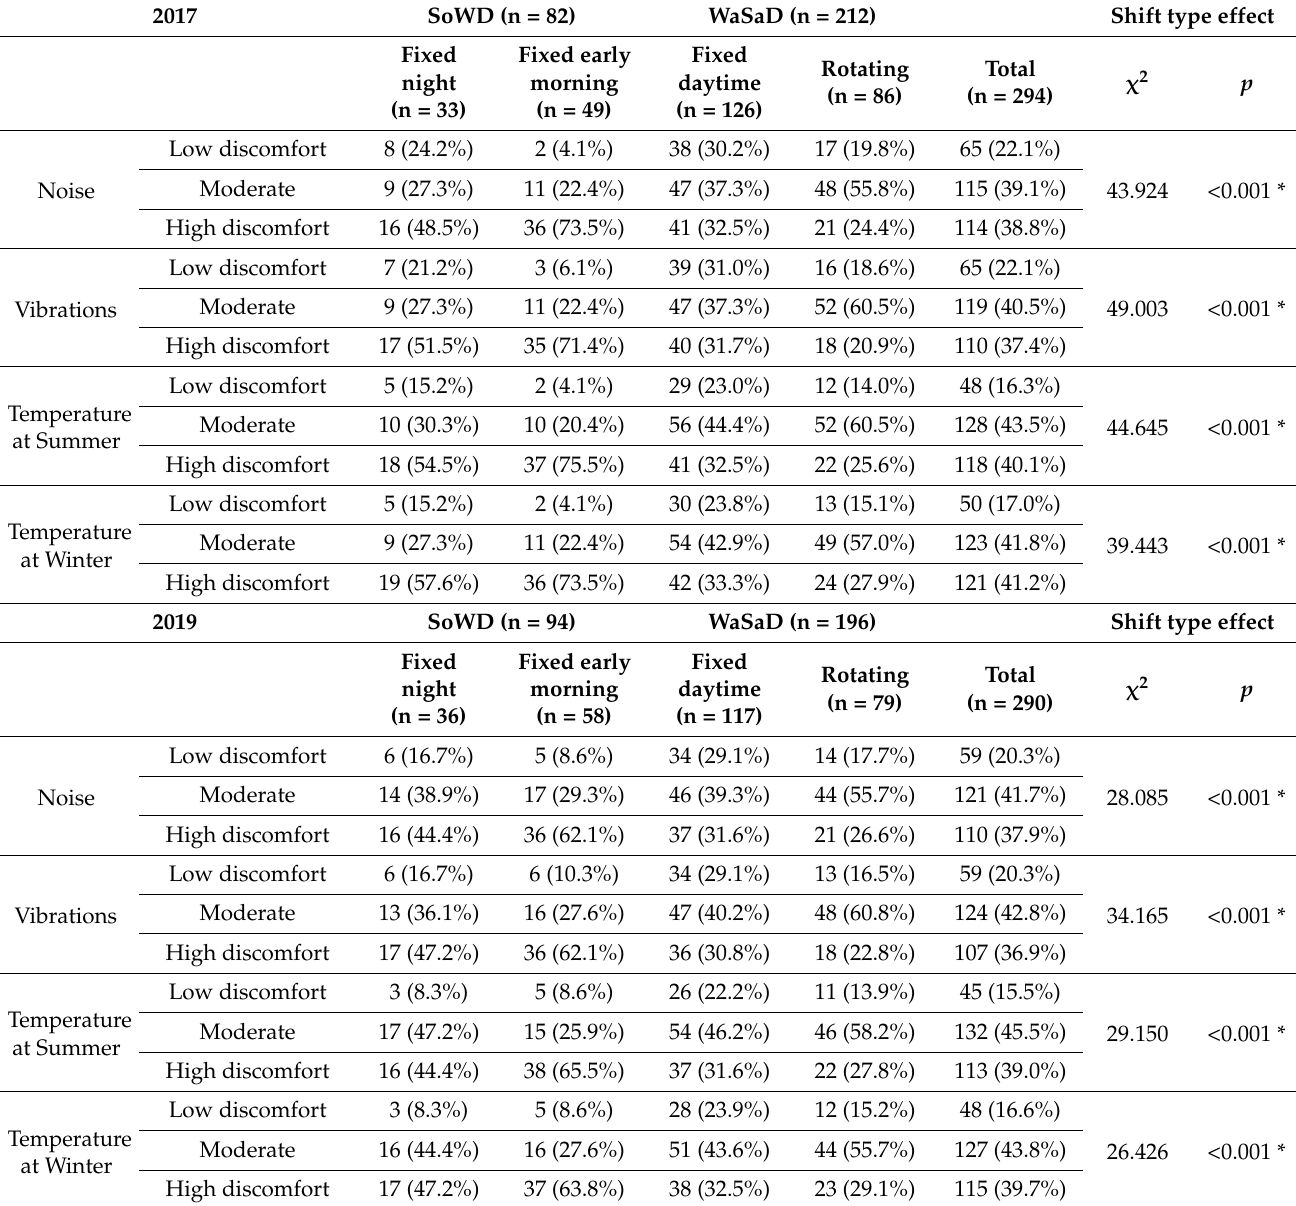
Table 4. Perception of environmental discomfort (Frequency (%)) in 2017 and 2019 by shift type and results of Chi-square test for homogeneity comparing shift